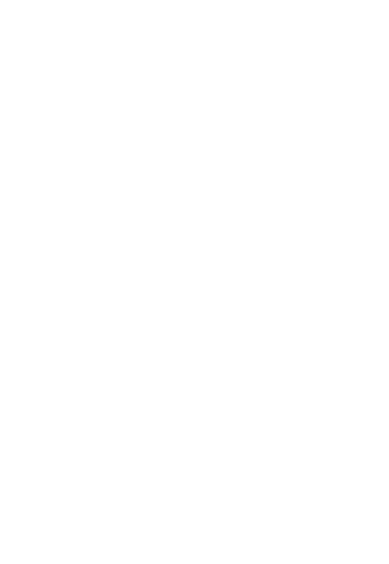
Figure 1. The atomic structures of the adsorption of ( a ) a H 2 O molecule, ( b ) a dissociated acetic acid molecule, and ( c ) an acetic acid molecule.